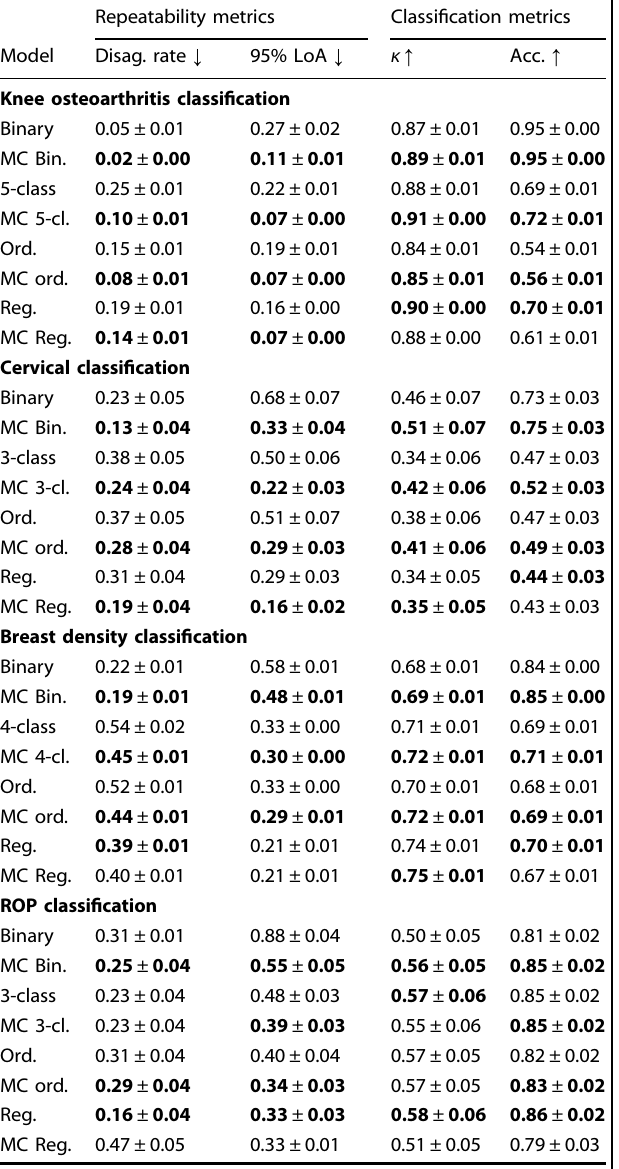
a Values in bold indicate the best model between MC and non-MC models where a statistical difference ( p value >0.05) was observed. The two fi rst columns measure the model repeatability where smaller values indicate better repeatability. The two last columns represent the model perfor- mance and high values indicate better classi fi cation. Binary models were trained with the following classes: Knee osteoarthritis: none and doubtful vs. mild, moderate, and severe – Cervix: normal vs. pre-cancer/cancer – Breast density: fatty and scattered vs. heterogeneous and dense – ROP: normal vs. pre-plus and plus. LoA Limits of agreement; κ : Quadratic weighted Cohen ’ s κ ; Acc . Accuracy; CI Con fi dence